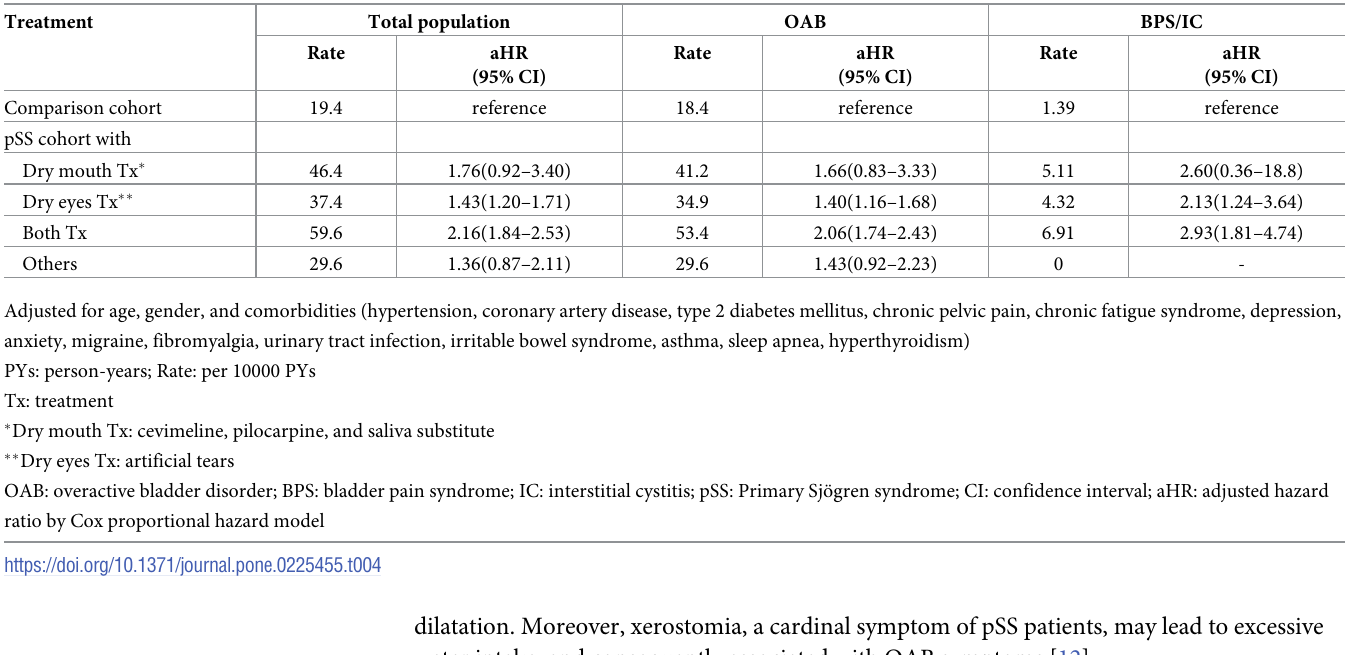
Table 4. Risks of OAB and BPS/IC by Sjogren syndrome-specific